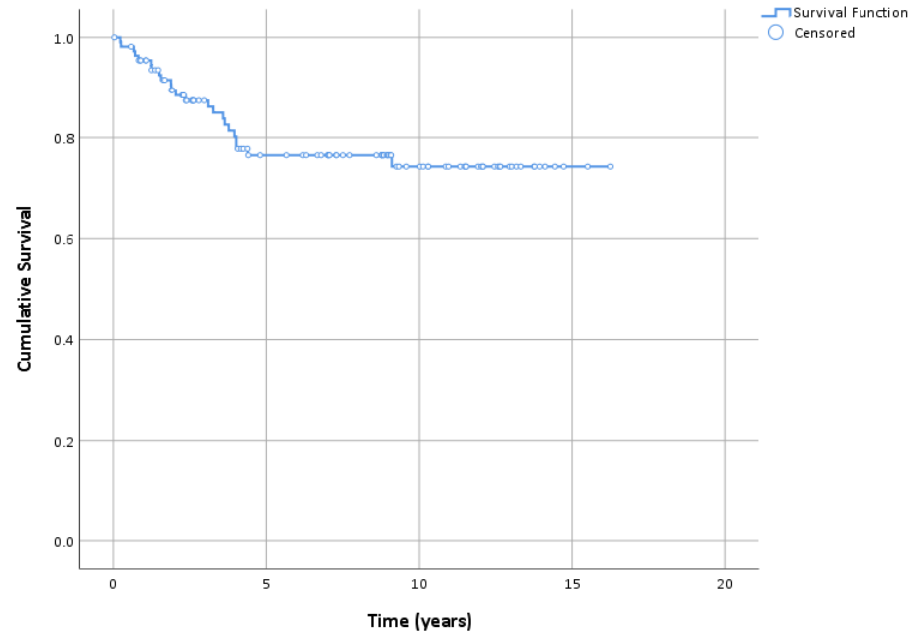
Figure 2. Kaplan–Meier plot of disease-free Figure 2. Kaplan – Meier plot of disease-free survival.